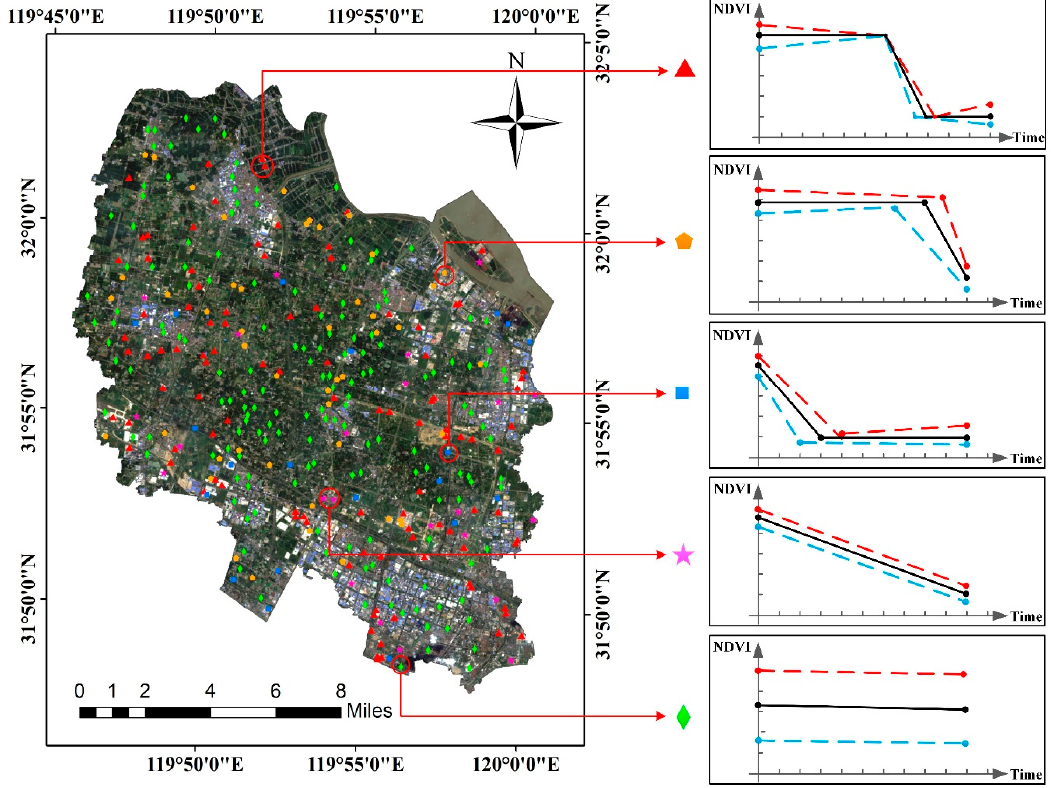
Figure 6. Sample types and distribution for SVM classification.